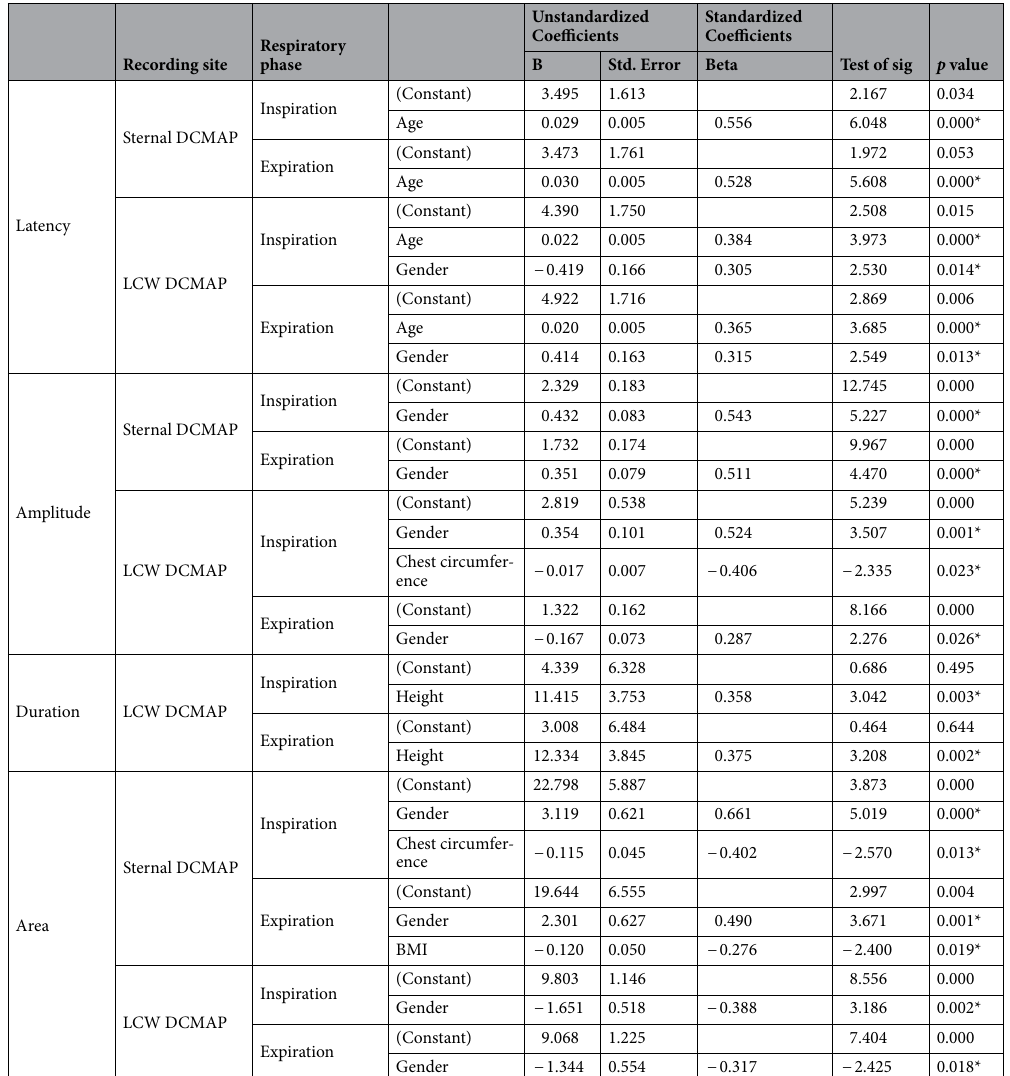
Table 5. Multivariate analysis for the parameters affecting DCMAP